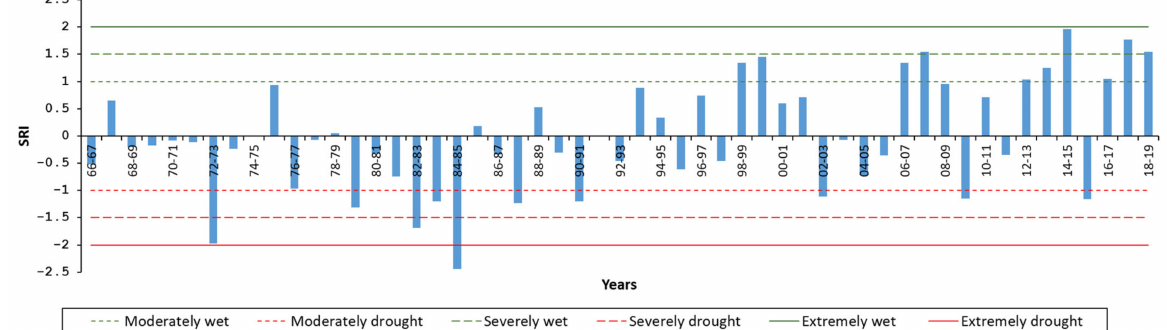
Figure 11. Annual SRI at EL Diem station for time series from 1966 to 2019.